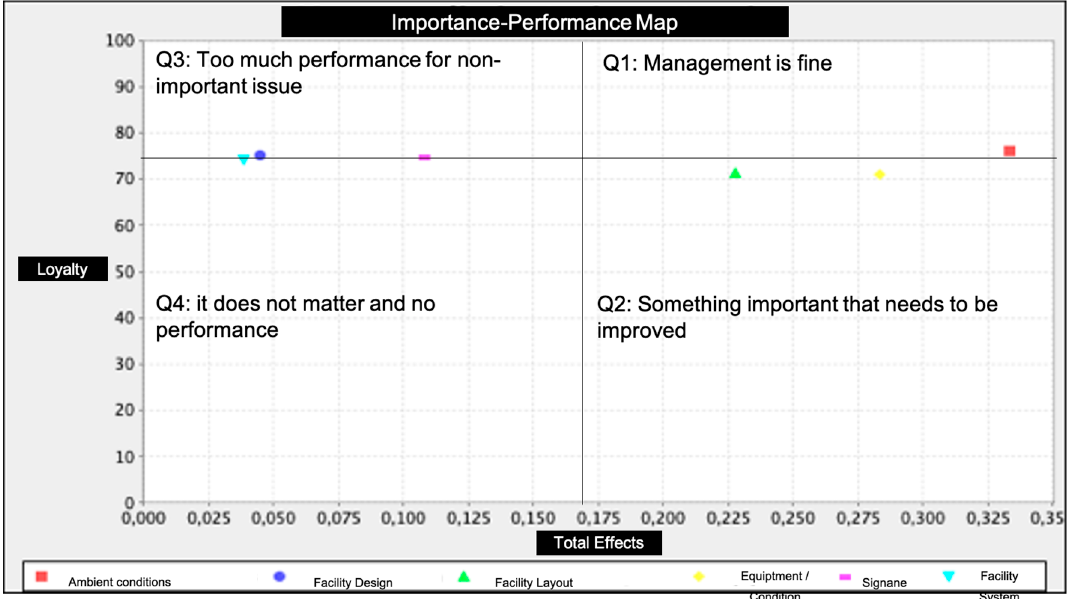
Figure 3. IPMA full data set. Note: Red: ambient condition; Strong blue: facility design; Green: facility